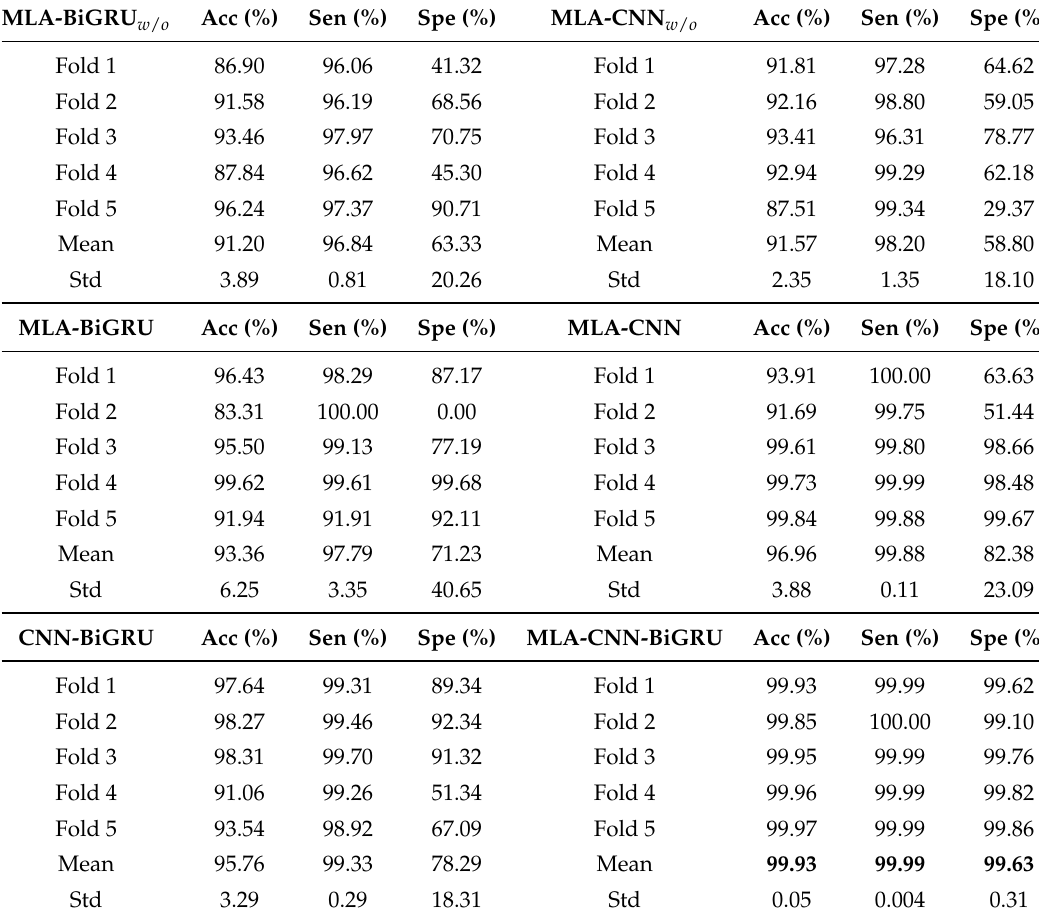
Table 2. Ablation experiments of MI detection by five-fold cross-validation under intra-patient scheme. MLA-BiGRU w / o